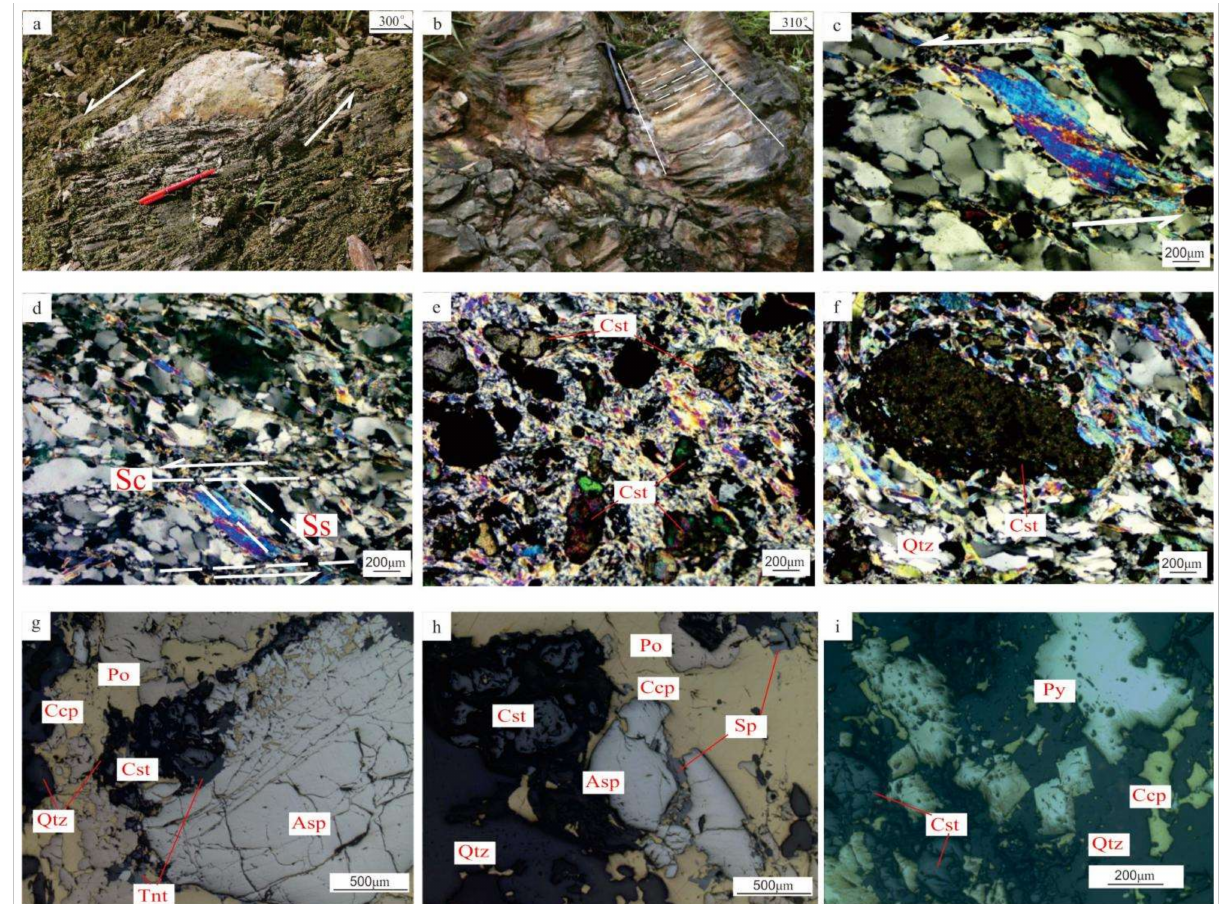
Figure 3. Photomicrographs of typical textures and mineral assemblages in the Jialong Sn–Cu deposit. ( a ) Ocellar quartz indicative of thrusting and shearing. ( b ) Schistosity plane with a folded lineation that was cut by late brittle fractures. ( c ) Mica fish indicative of ductile deformation and sinistral shear. ( d ) S–C fabric indicative of sinistral movement. ( e ) Fine-grained and patchily distributed cassiterite (Cst). ( f ) Patchy cassiterite surrounded by quartz (Qtz). ( g ) Dissolved (Ccp) chalcopyrite, (Tnt) tintinaite, fractured (Asp) arsenopyrite, cassiterite, and (Po) pyrrhotite. ( h ) Fractured arsenopyrite infilled by late (Sp) sphalerite. ( i ) Allotriomorphic granular (Py) pyrite associated with chalcopyrite and